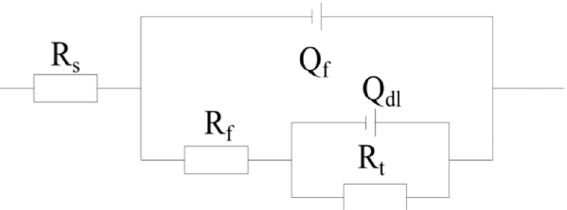
Figure 5. The equivalent circuit fitted by the data from the EIS measurement.